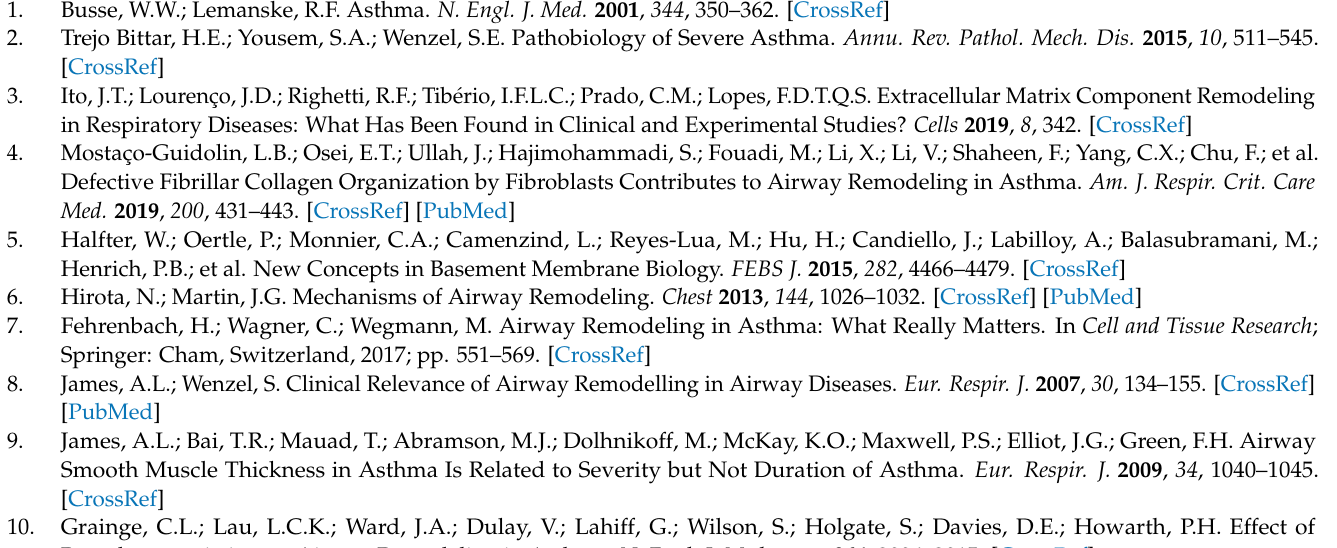
subjects. Table S3: Differences in the percentage of eosinophils expressing studied integrin chains in comparison of asthma patients with persistent or non-persistent airflow limitation and control subjects. Figure S1: Design of flow cytometry panels and gating strategy used to measure the surface integrin expression in blood T-cells and eosinophils. Figure S2: Design of flow cytometry panels and gating strategy used to measure the surface expression of integrin chains on bronchoalveolar lavage (BAL) T-cells and eosinophils. Figure S3: Representative immunohistochemistry images (600 × ) of α α 1 integrin subunit, 2 integrin subunit, type I collagen, and type IV collagen expression in the bronchial